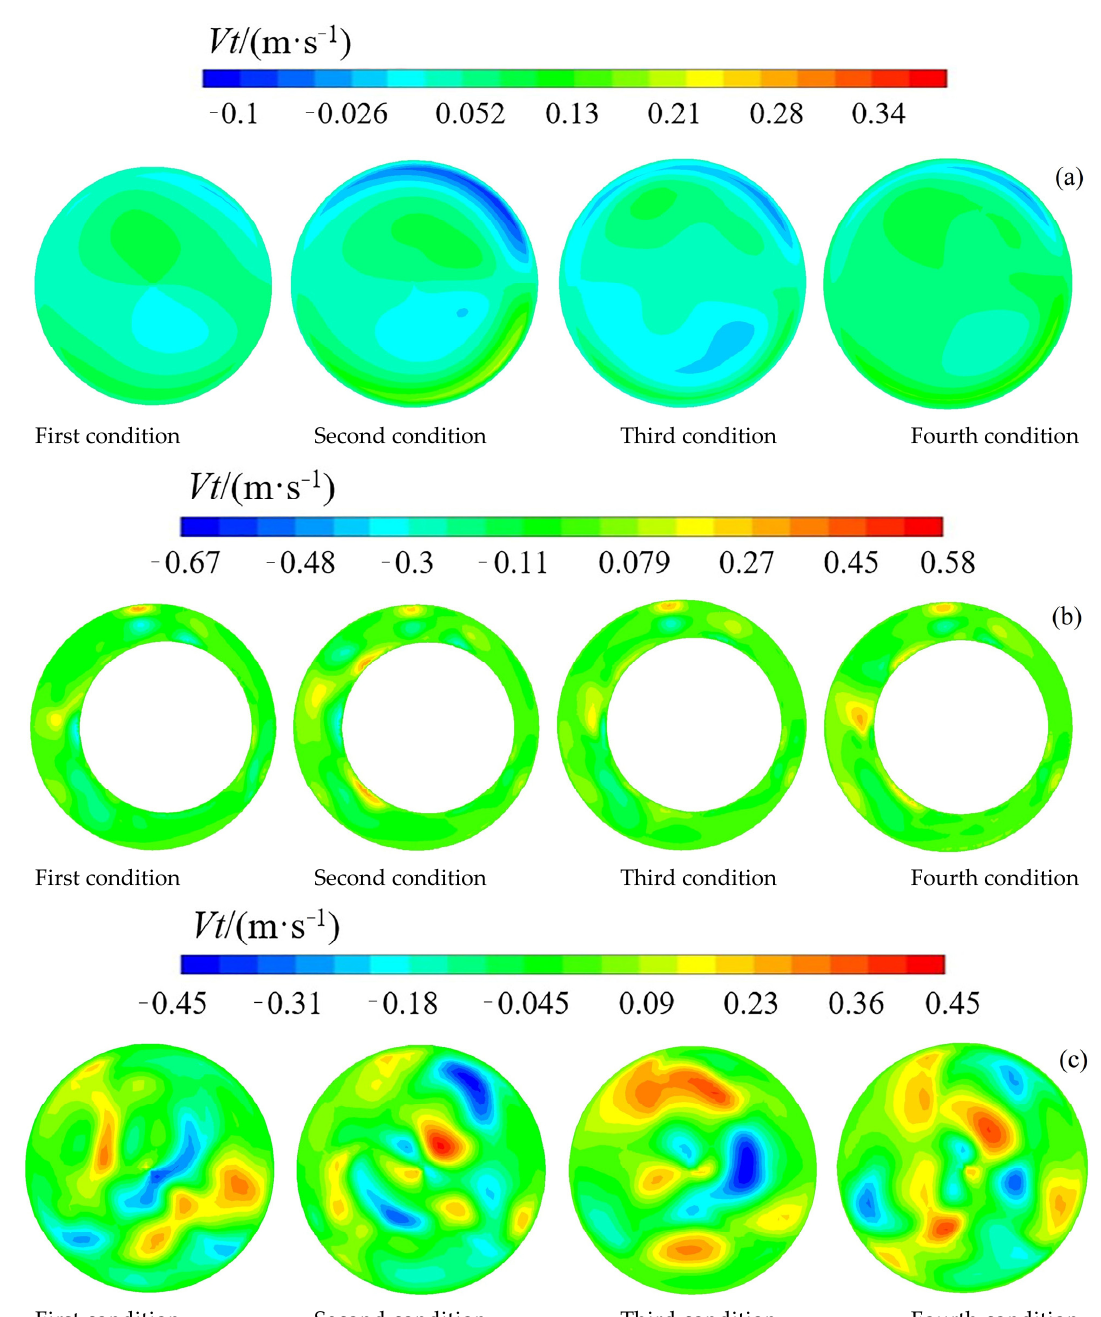
Figure 10. The circumferential flow velocity distribution cloud map of the characteristic section when the pipeline truck starts at different positions of the pipe bend (the conditions meaning the centroid of the wheeled capsule had angle locations of θ ): ( a ) upstream of the wheeled capsule; ( b ) gap zone between the capsule and the pipe; ( c ) downstream of the wheeled capsule.